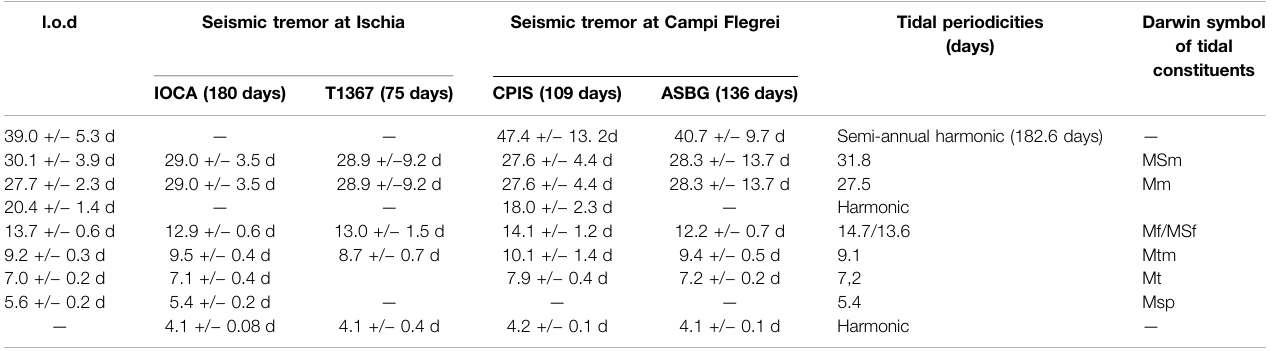
TABLE 1 | Tidal constituents extracted in the l.o.d. and the seismic tremor for four seismic stations: IOCA and T1367 at Ischia island, CPIS and ASBG at Campi Flegrei, and identi fi ed using Ray and Erofeeva (2014). l.o.d Seismic tremor at Ischia Seismic tremor at Campi Flegrei Tidal periodicities